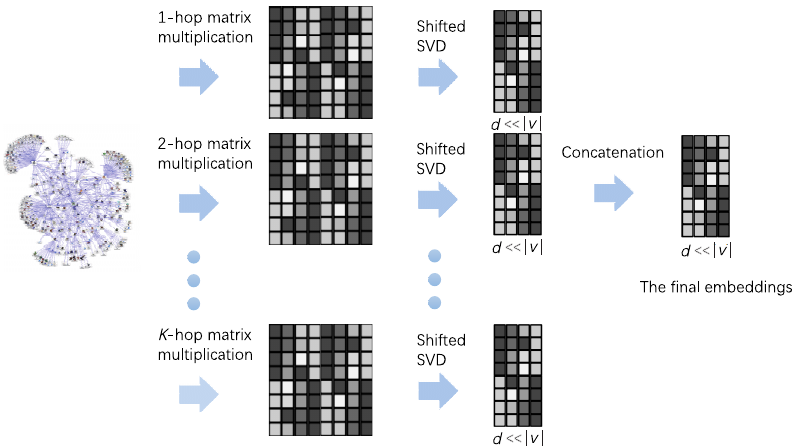
Fig. 2 The illustration of GraRep [37]